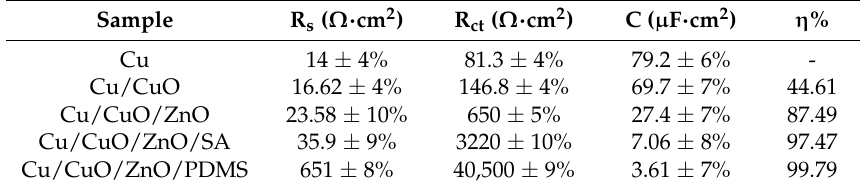
Figure 12. Nyquist plot for the modified Cu/CuO/ZnO/SA and Cu/CuO/ZnO/PDMS electrodes in 3.5% NaCl solution. The CuO/ZnO/PDMS sample showed a higher anticorrosion efficiency compared to the other samples. Table 2. Impedance parameters and anticorrosion efficiencies of different samples in 3.5% NaCl solution.